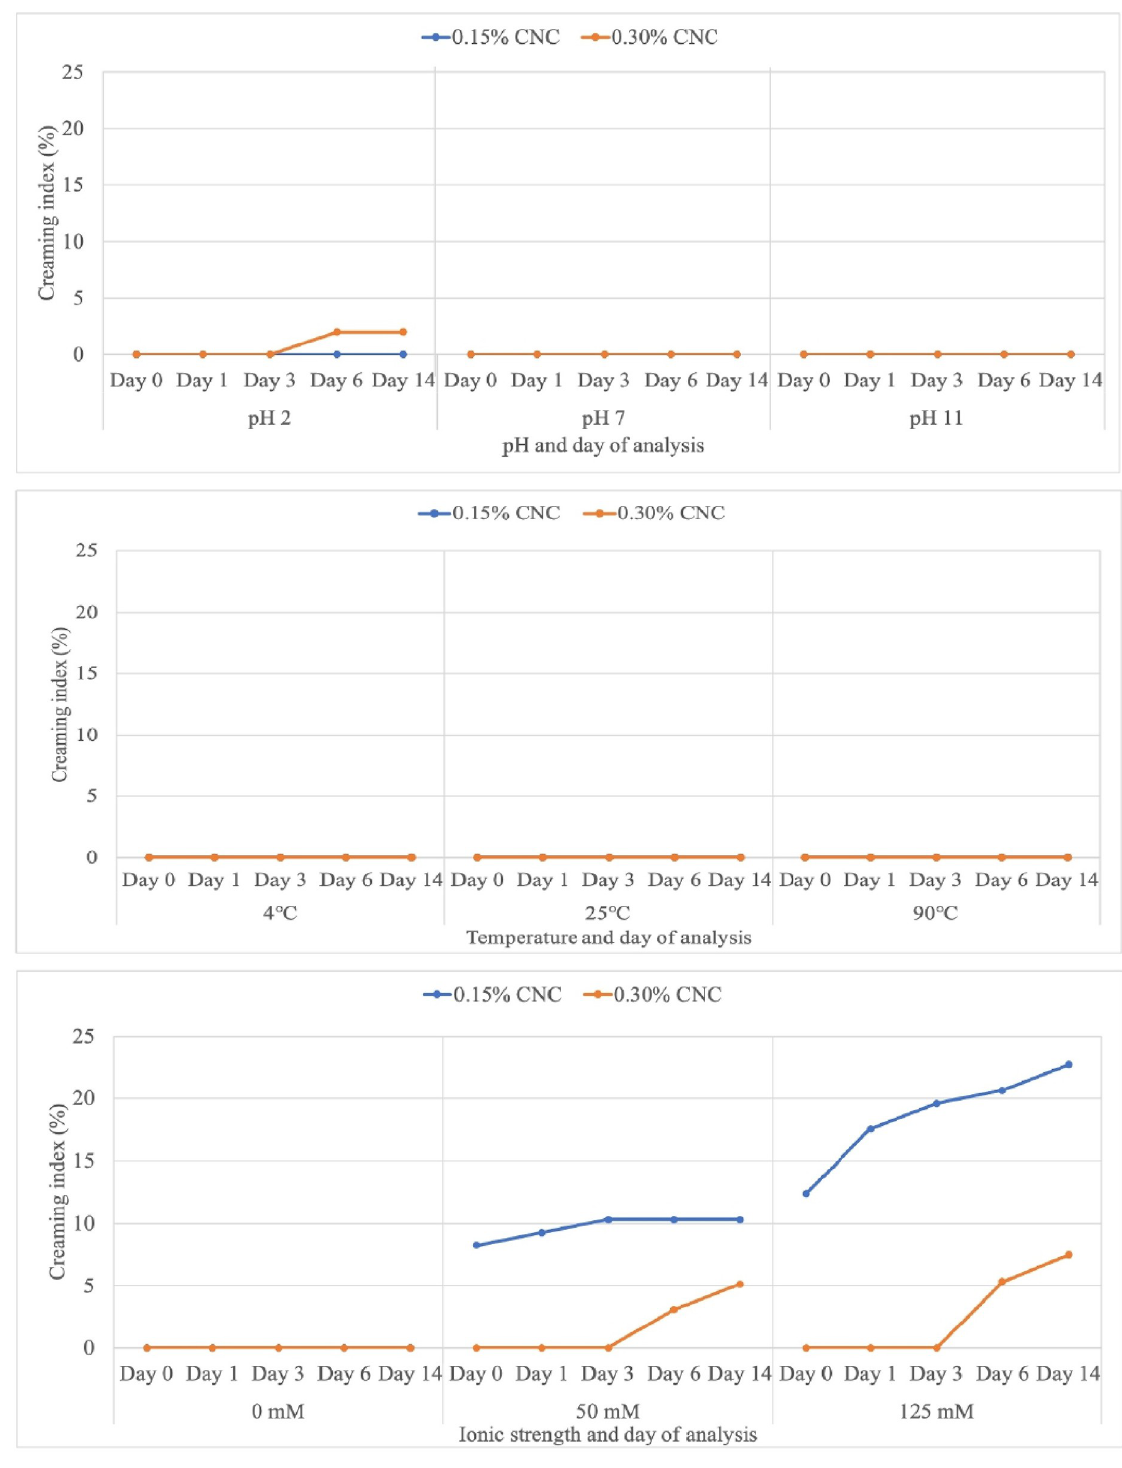
Fig 9. Creaming index of CNC 0.15 -PE and CNC 0.30 -PE at pH (2, 7, 11); centre) temperature (4˚C, 25˚C and 90˚C); bottom) ionic strength (0mM, 50mM and 124mM) on Day 0, 1, 3, 6 and 14.